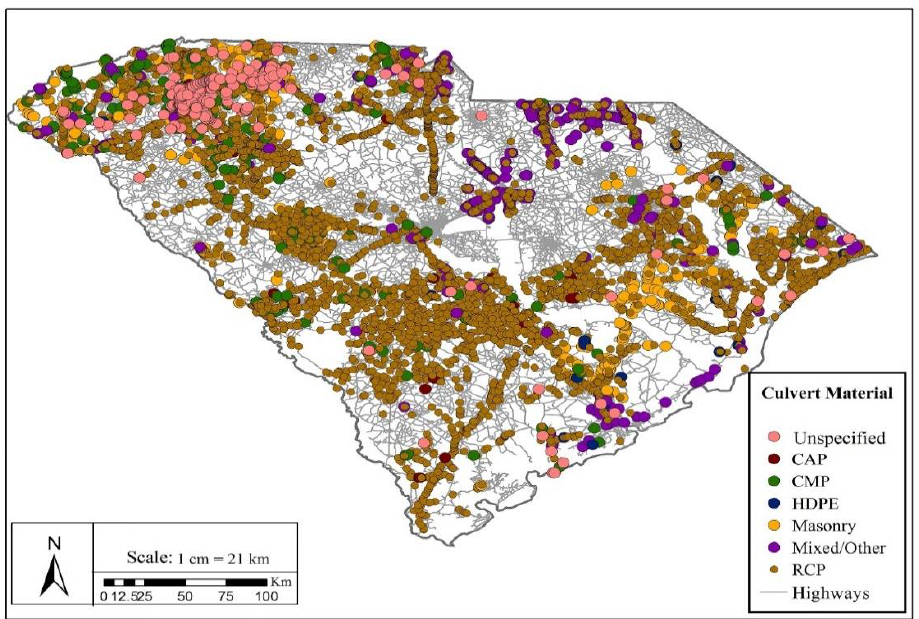
Figure 3. A map of all the culverts recorded in the South Carolina Department of Transportation (SCDOT)’s inventory database (CAP—corrugated aluminum pipe; CMP—corrugated metal pipe; HDPE—high density polyethylene; RCP—reinforced concrete pipe).